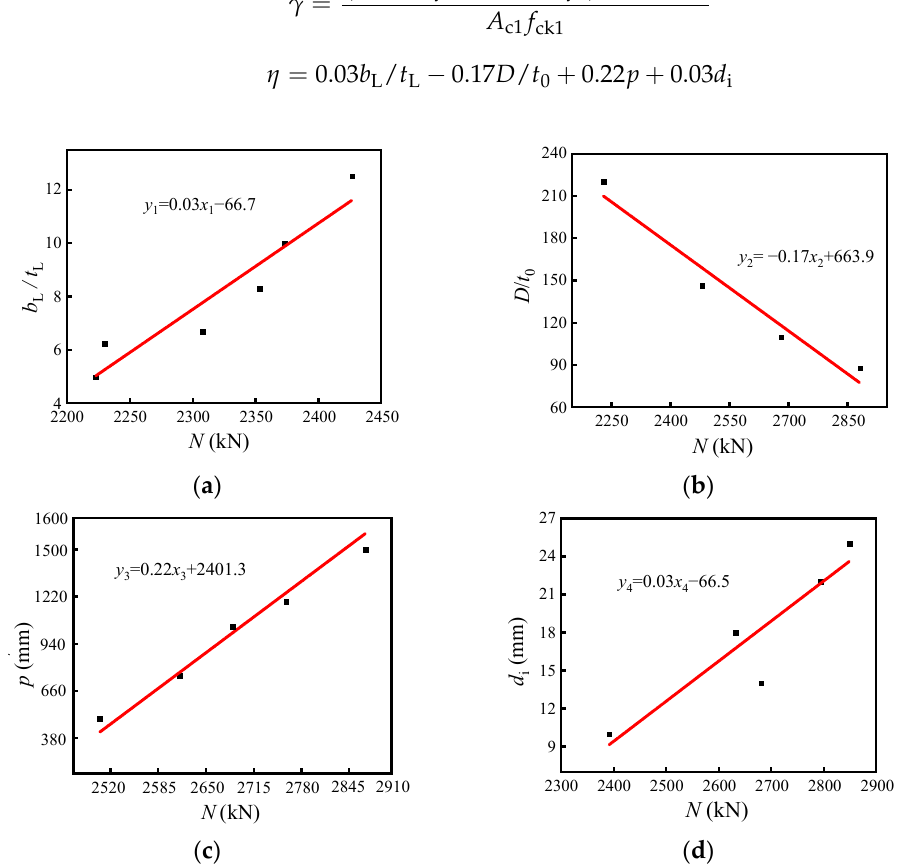
Figure 17. Fitting pattern of each parameter. ( a ) Width–thickness ratio of Spiral Rib ( b ) Width–thickness ratio of Steel Pipe ( c ) Pitch ( d ) Bar Diameter.